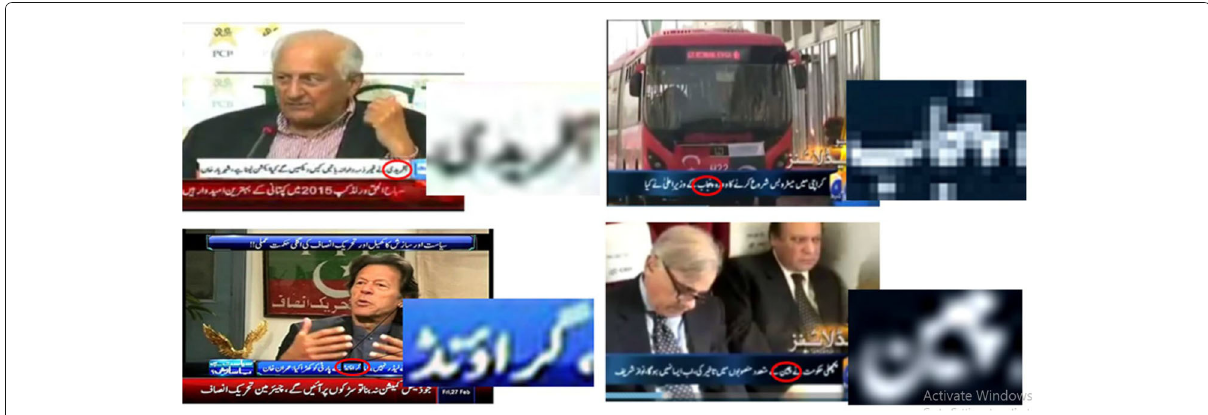
Fig. 3 Low-resolution text in video